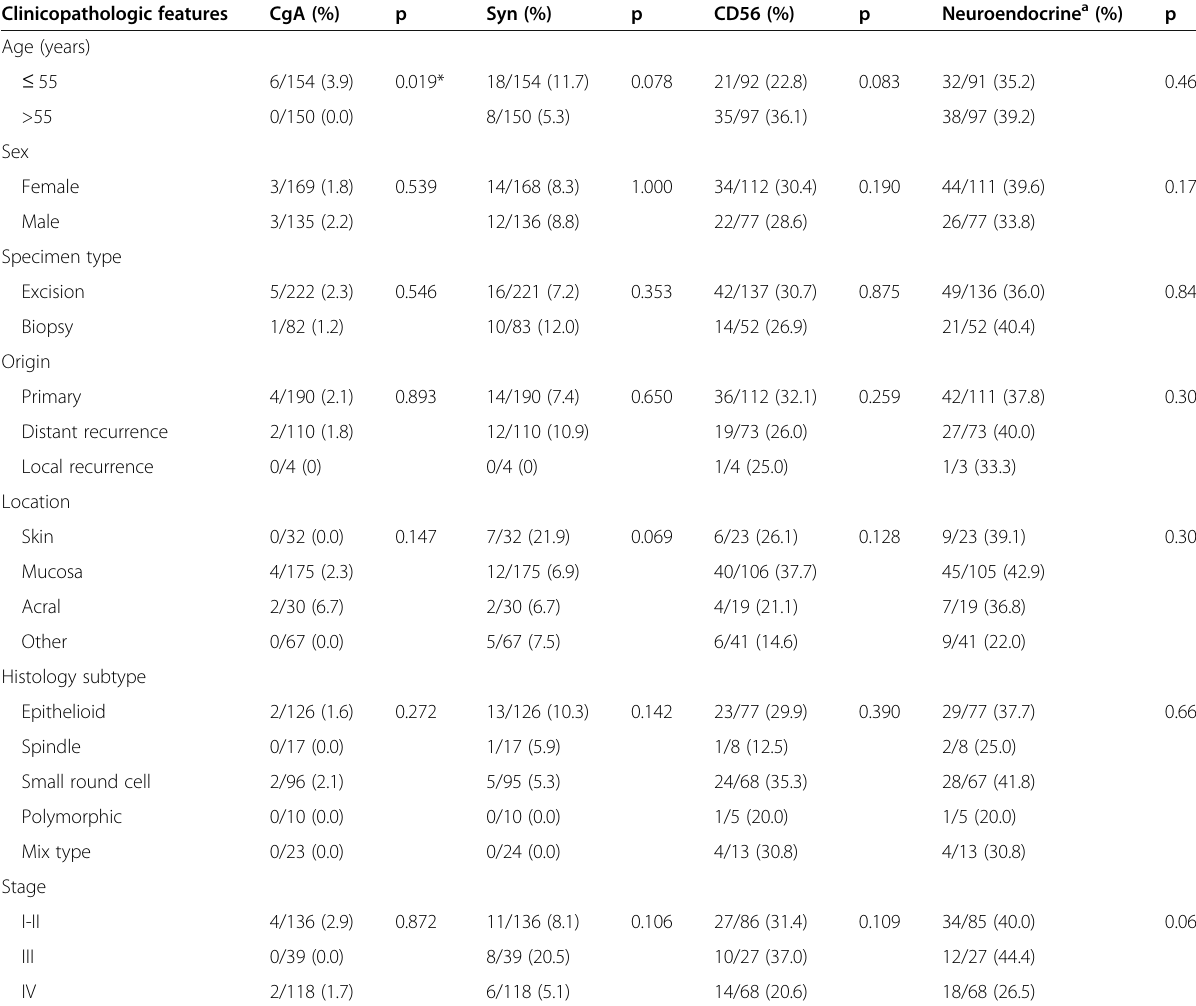
Table 3 Correlation between neuroendocrine marker expression and clinicopathological features in melanoma patients Clinicopathologic